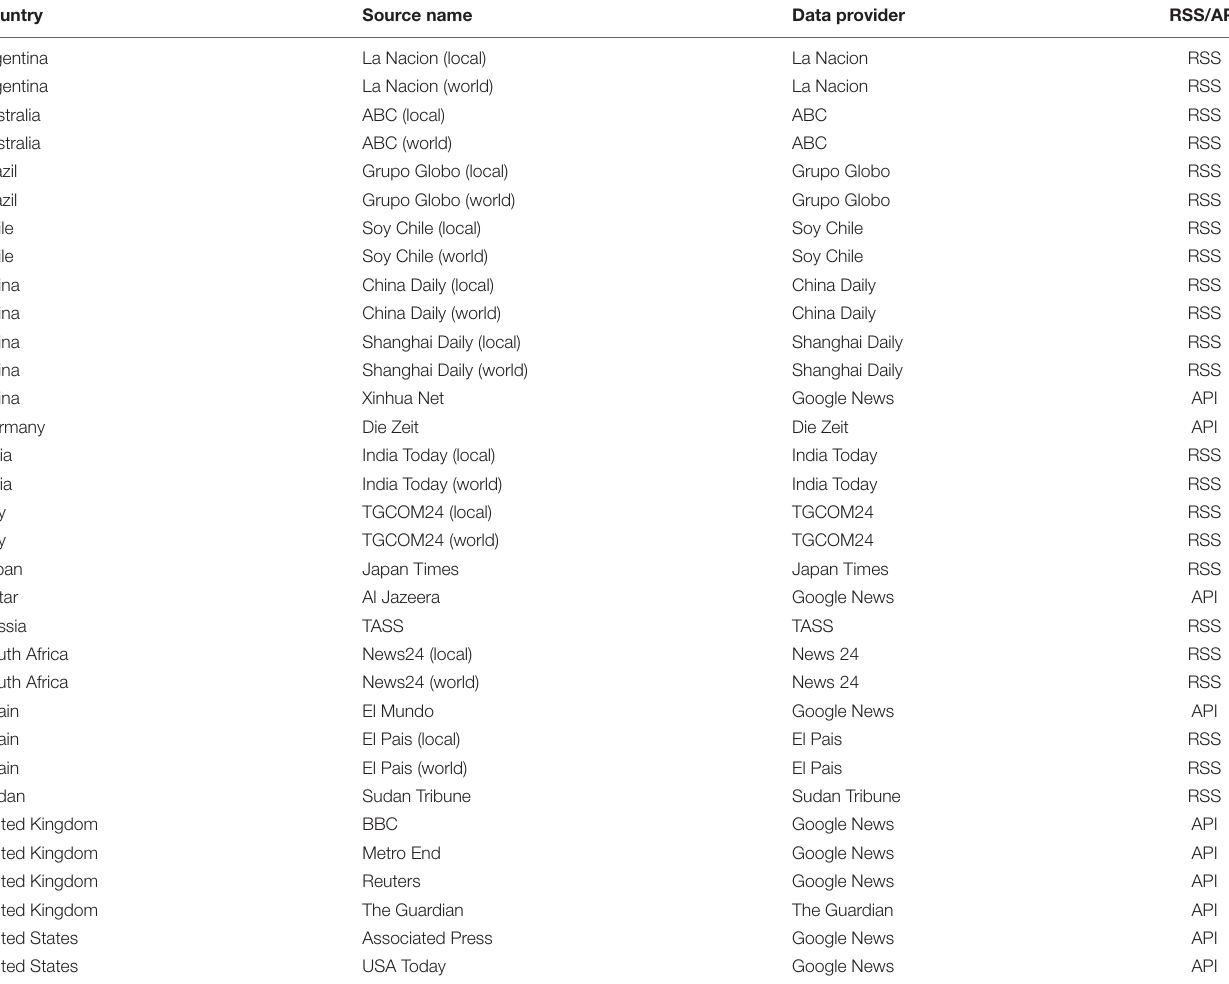
TABLE 1 | List of news agency internet sites mined for